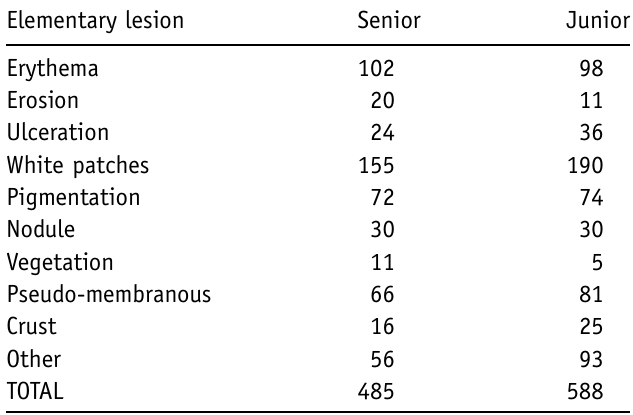
Table I. Distribution of the number of elementary